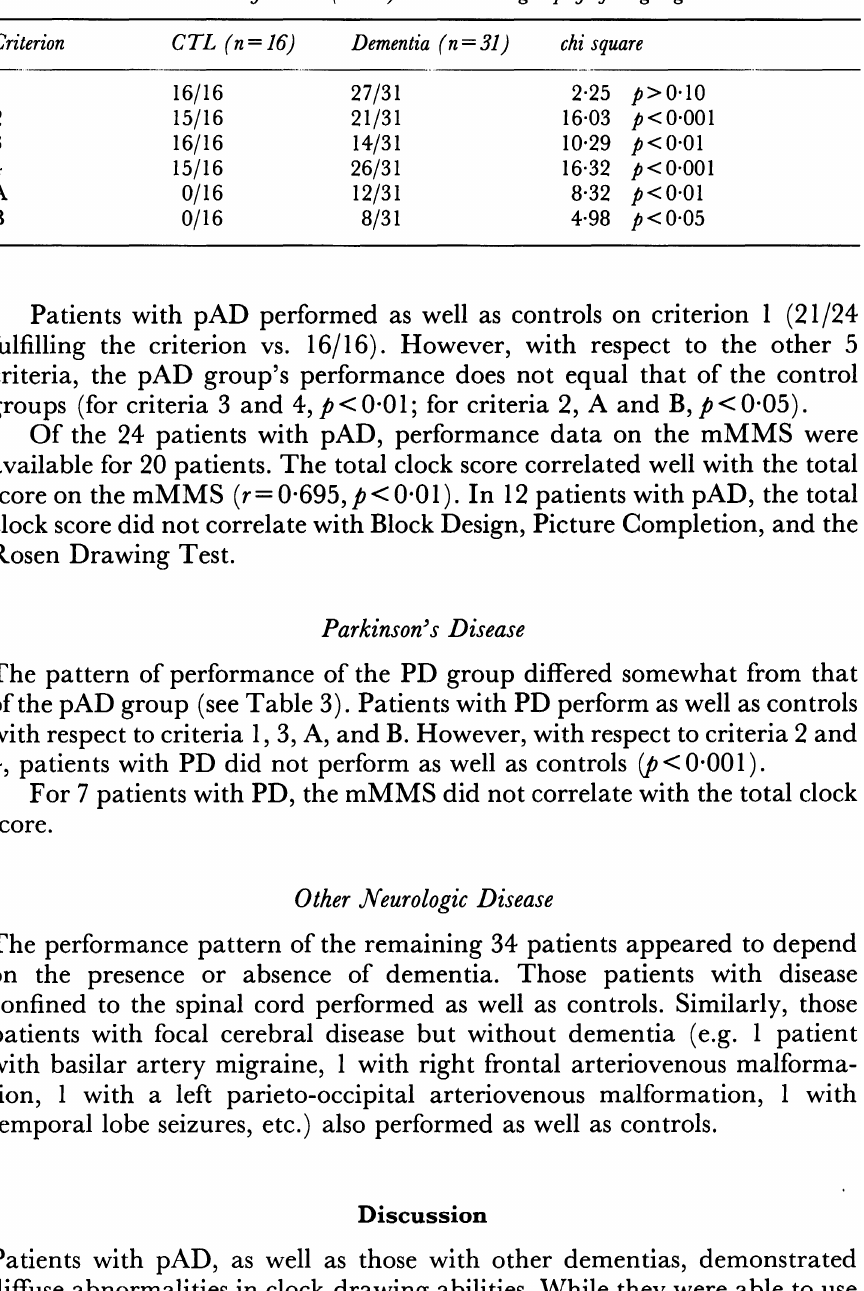
TABLE 4. Fraction of control (CTL) and dementia groupsfuljilling a given